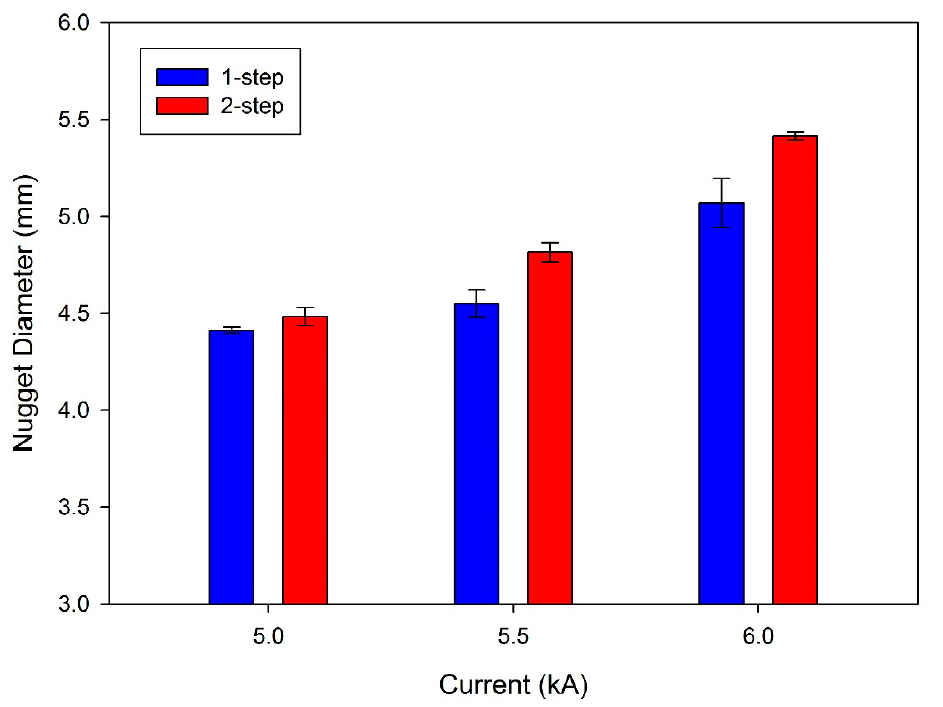
Figure 4. 15B22 nugget diameter variations at weld current from 5.0 to 6.0 kA in the one-step and the two-step RSW.